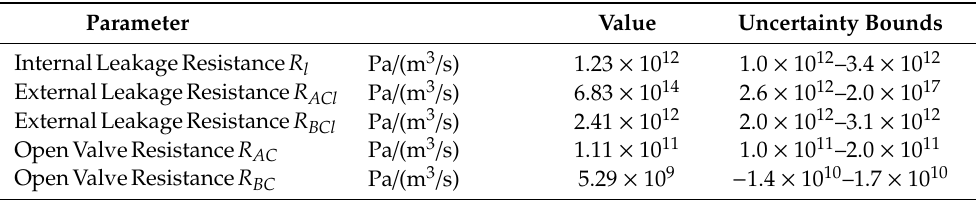
Table 4. Best fit parameters for Valve B (3D-printed spool).